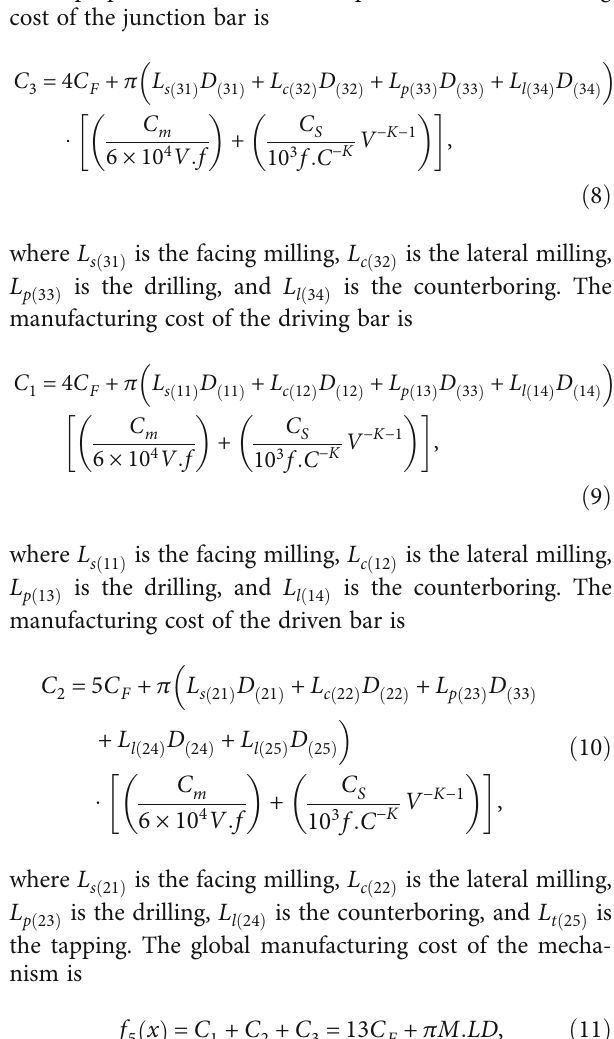
Table 2: Dimension values of thumb ’ s mechanism [20, 24].